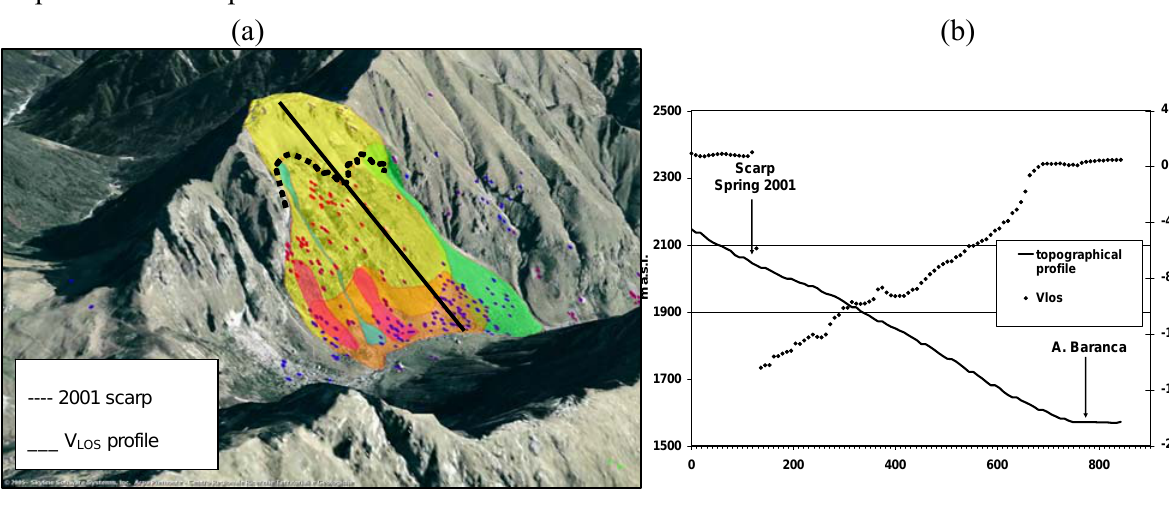
Figure 8. Comparison between the VLOS and the different typologies of movements in the Alps. 1: tectonic activity; 2: slope instability, 3: natural subsidence due to consolidation